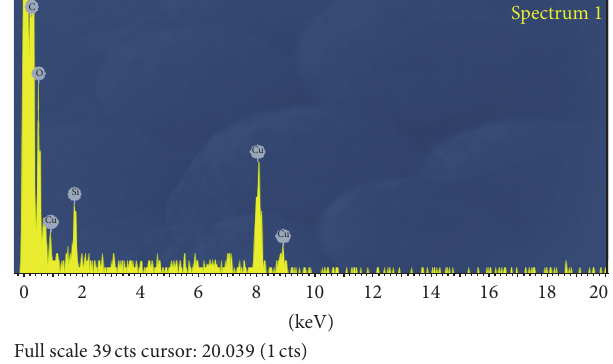
Figure 5: EDX results obtained for CuO NPs under